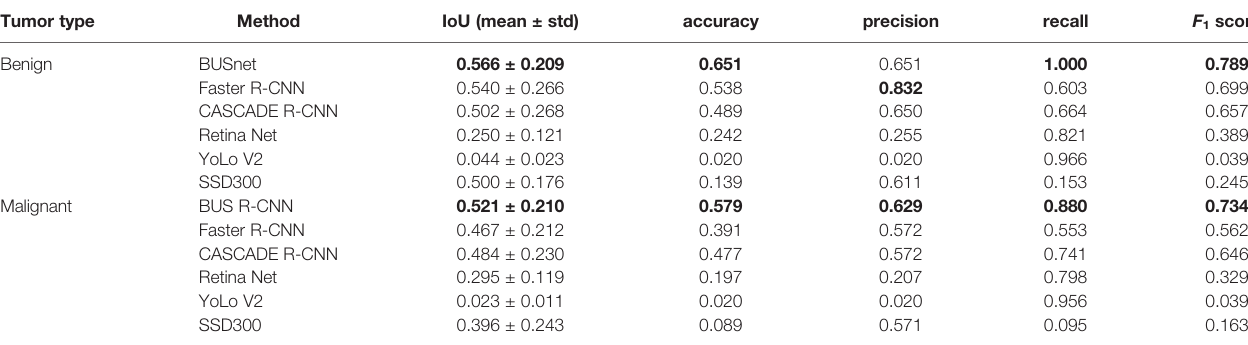
TABLE 2 | Performance metrics for six